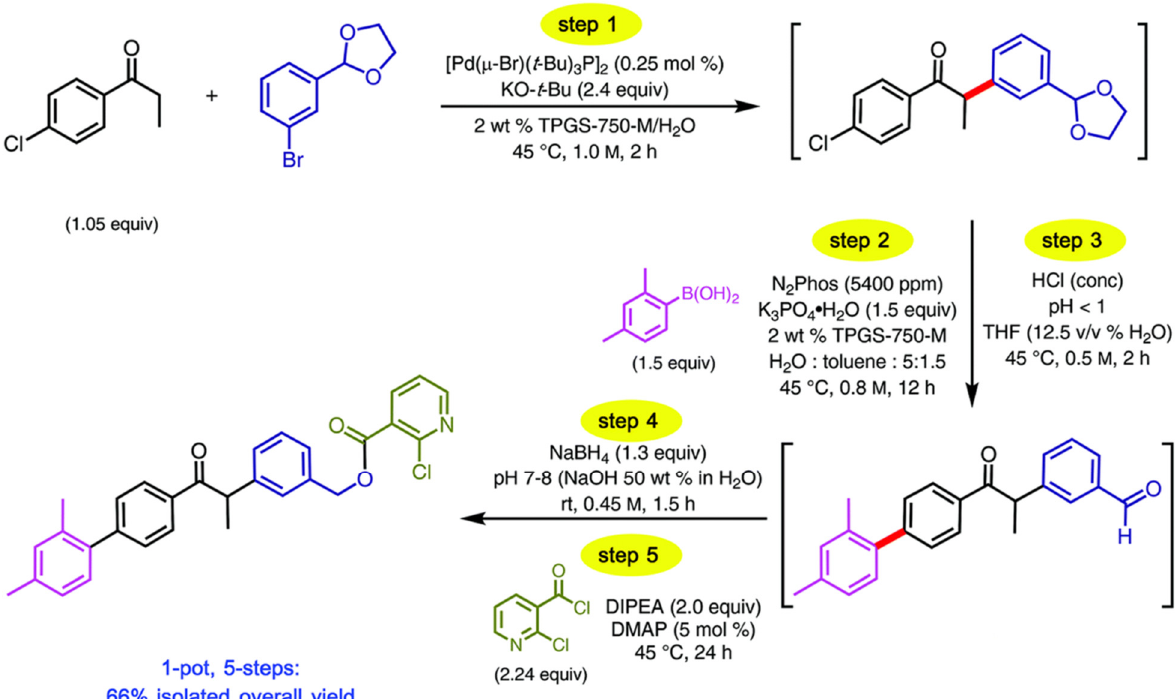
Figure 9. One-pot, five-step sequence starting with α -arylation of ketone using Pd-based catalysts in TPGS-750-M micelles. Red indicates bond formation. The colors indicate how the reactants from each step were attached to form the final product. The product was recovered by extraction with ethyl acetate and flash chromatography, with an overall isolated yield of 66%. Adapted from [127] with permission.